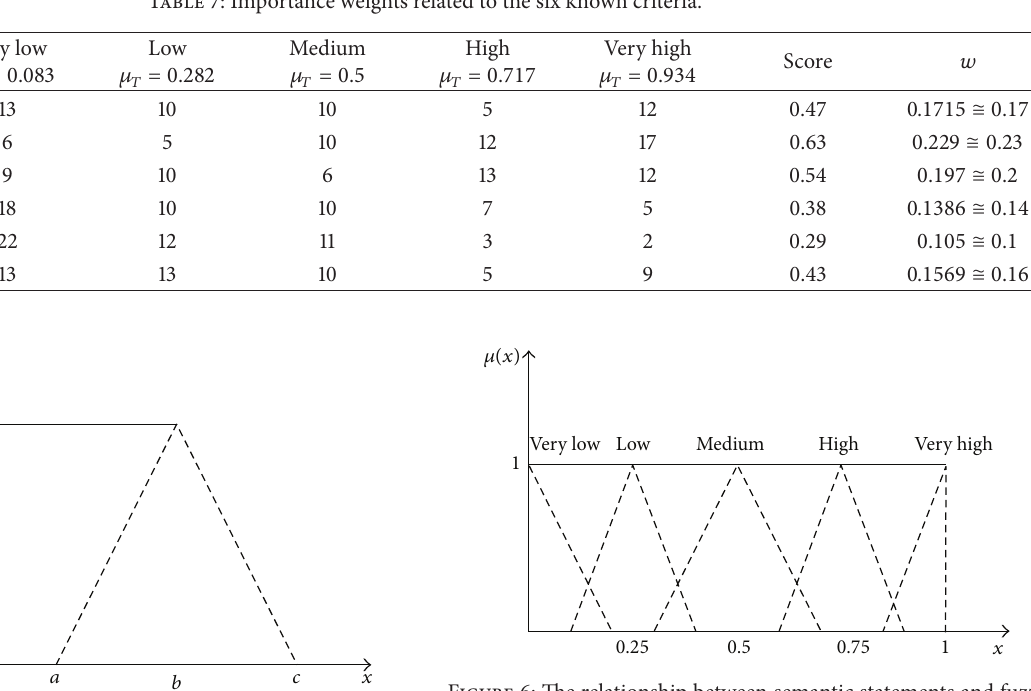
Figure 6: The relationship between semantic statements and